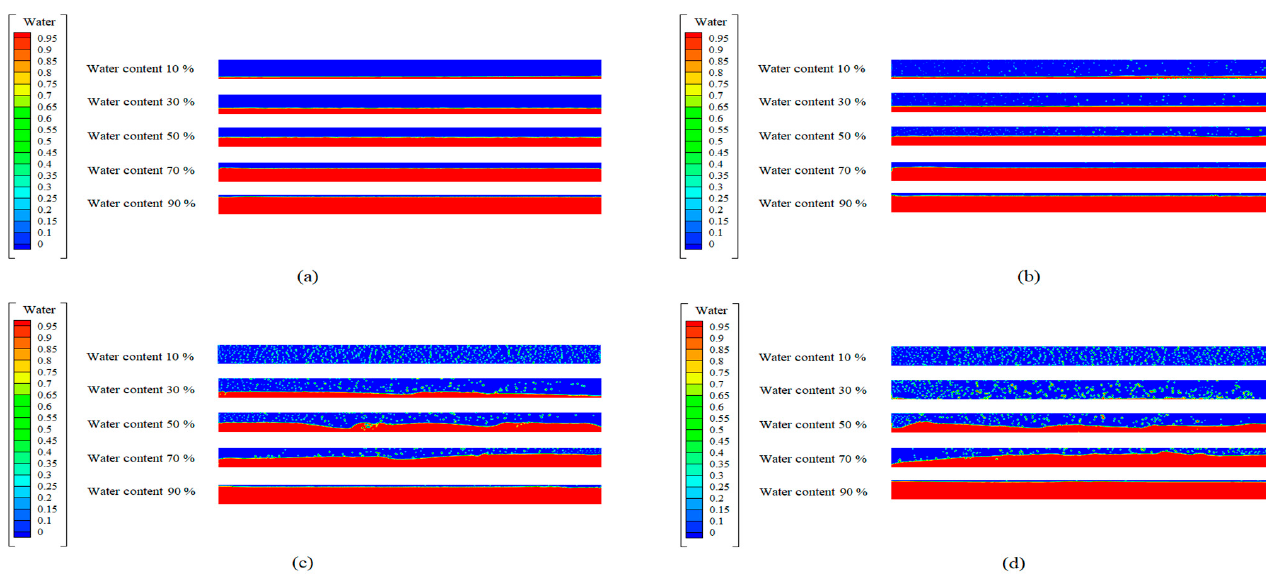
Figure 4. Distribution of the water phase inside a straight pipe with different gas superficial velocities, where ( a ) 0.5 m/s, ( b ) 1 m/s, ( c ) 3 m/s, and ( d ) 5 m/s.